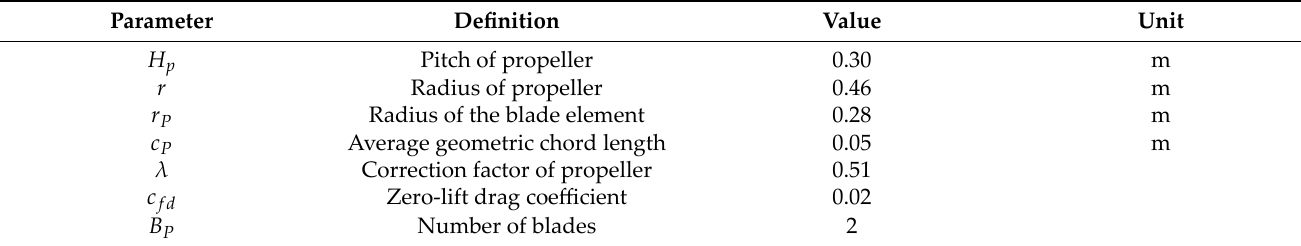
Figure 4. The force analysis diagram of the blade‑element theory. Table 2. Main parameters used in the rotor